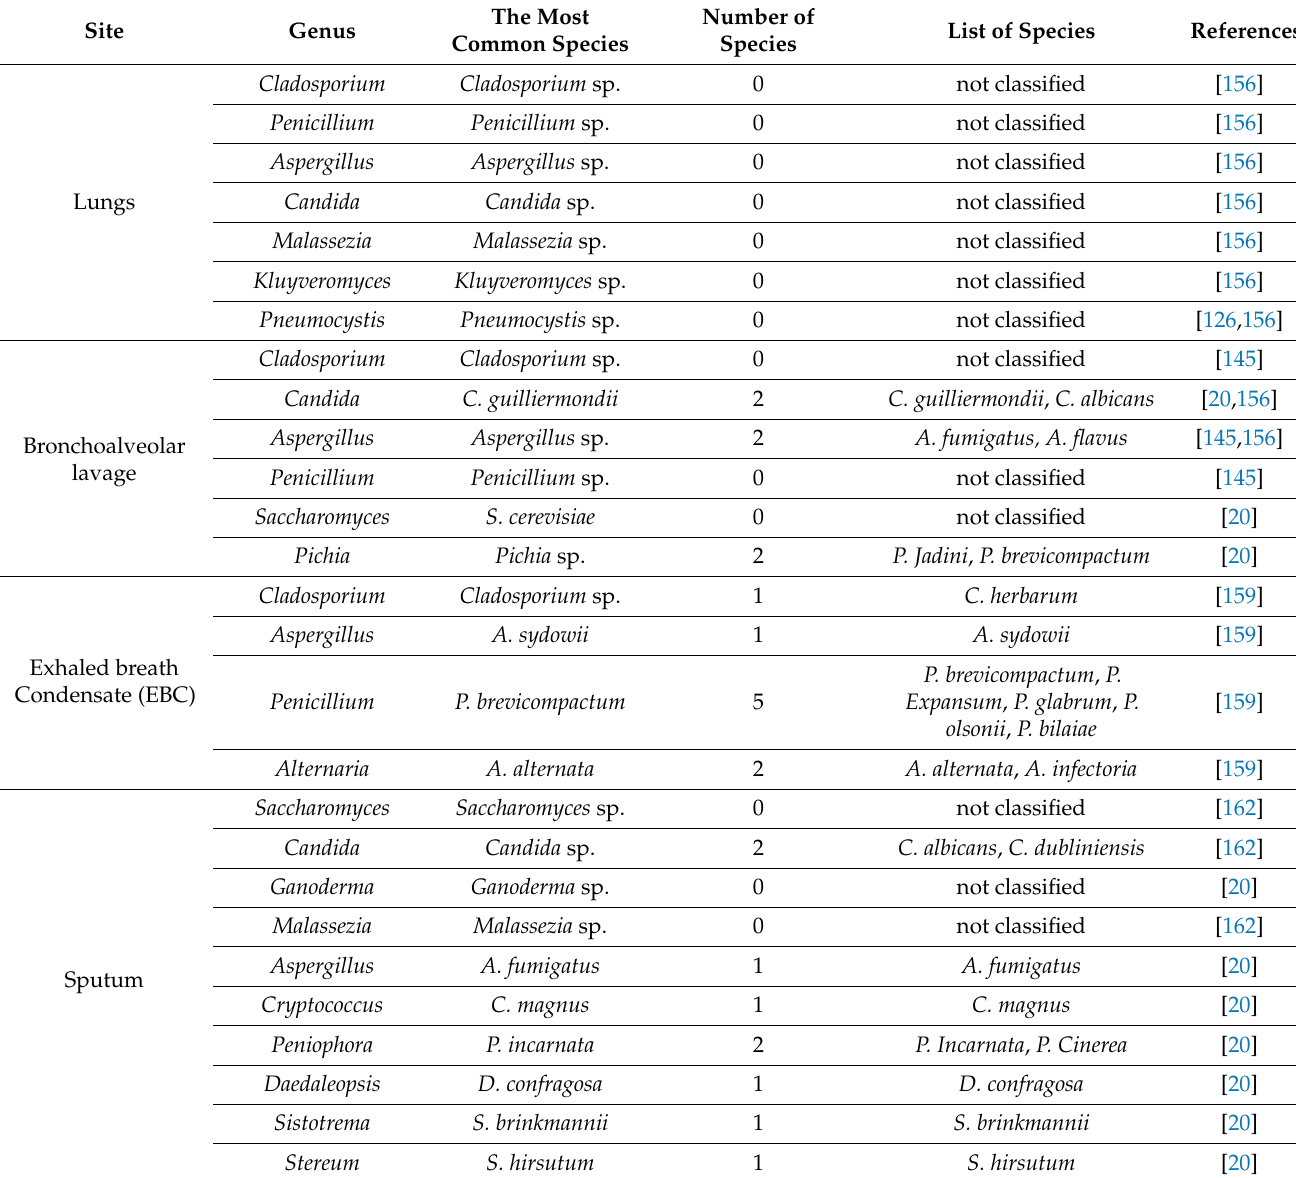
Table 8. The list of chosen respiratory tract mycobiome colonizers. The table summarizes representa- tive taxa, number and summary of all species described in the